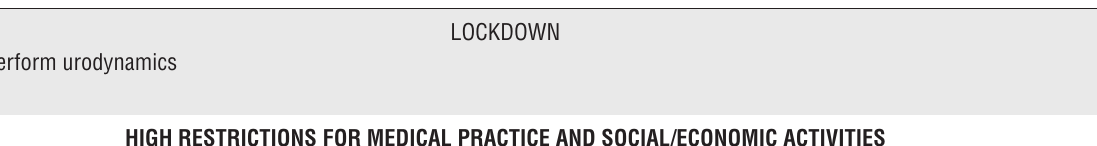
Table 1 - Recommendations for urodynamic practice according to local government restrictions and risk classification during COVID-19